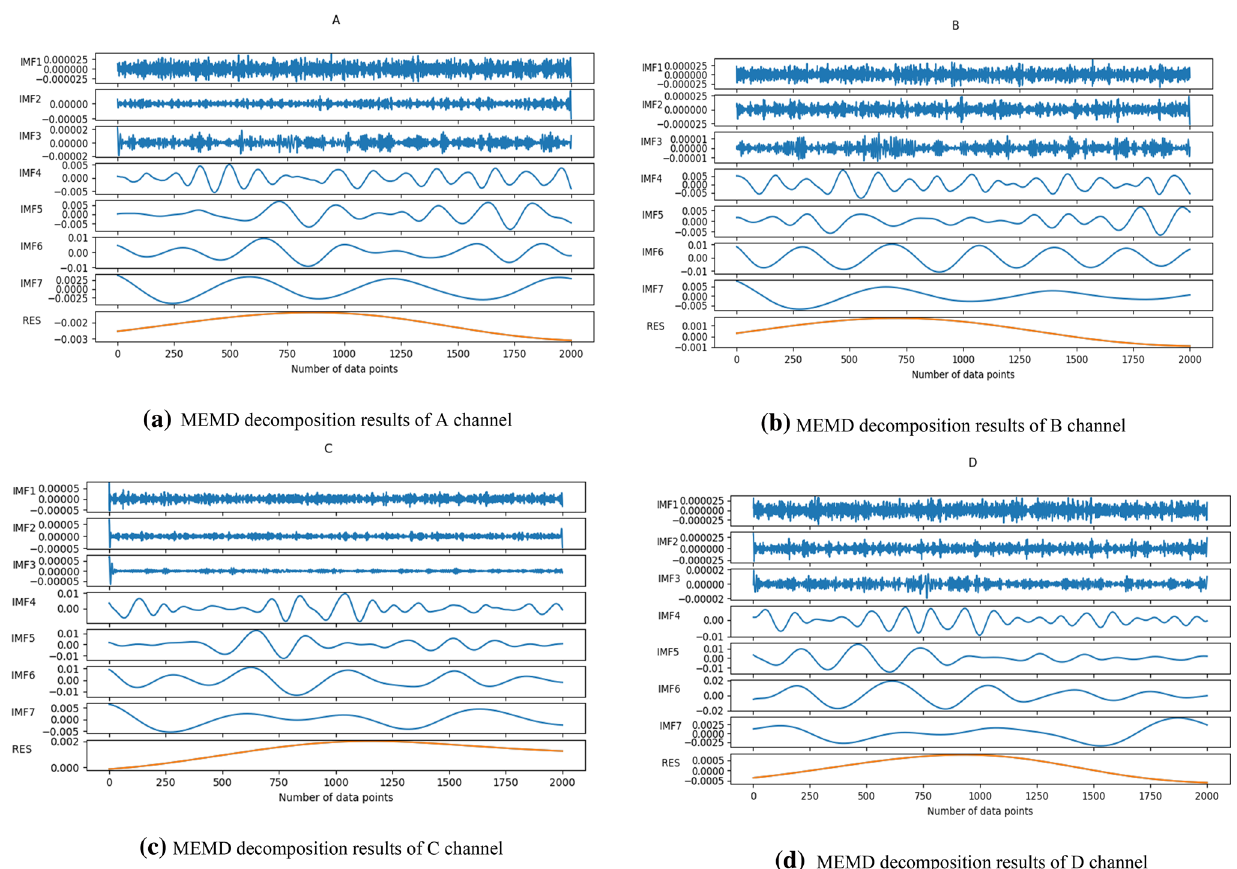
Fig. 5 MEMD decomposition of